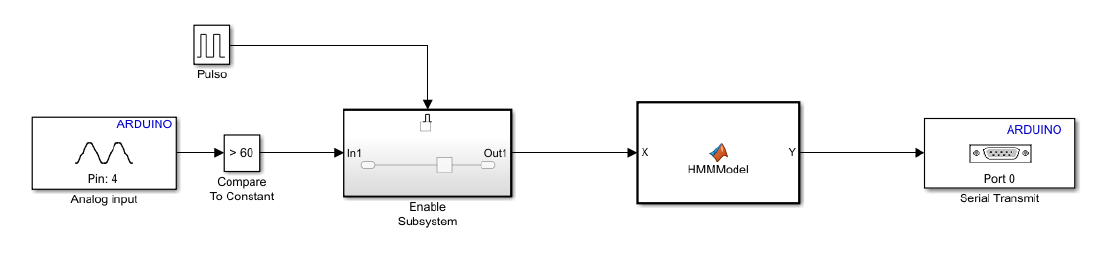
Figure 9. Model developed in Simulink to embedded on the